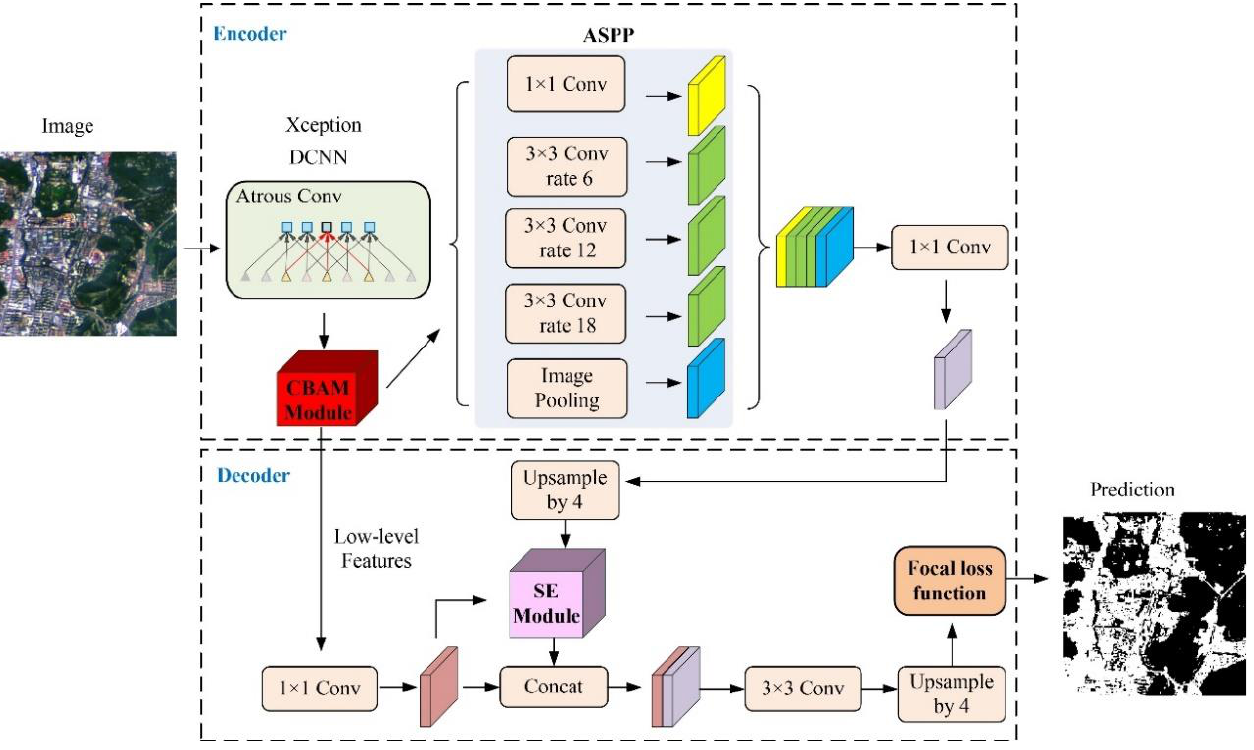
Figure 4. Structure of the improved Deeplabv3+ model.